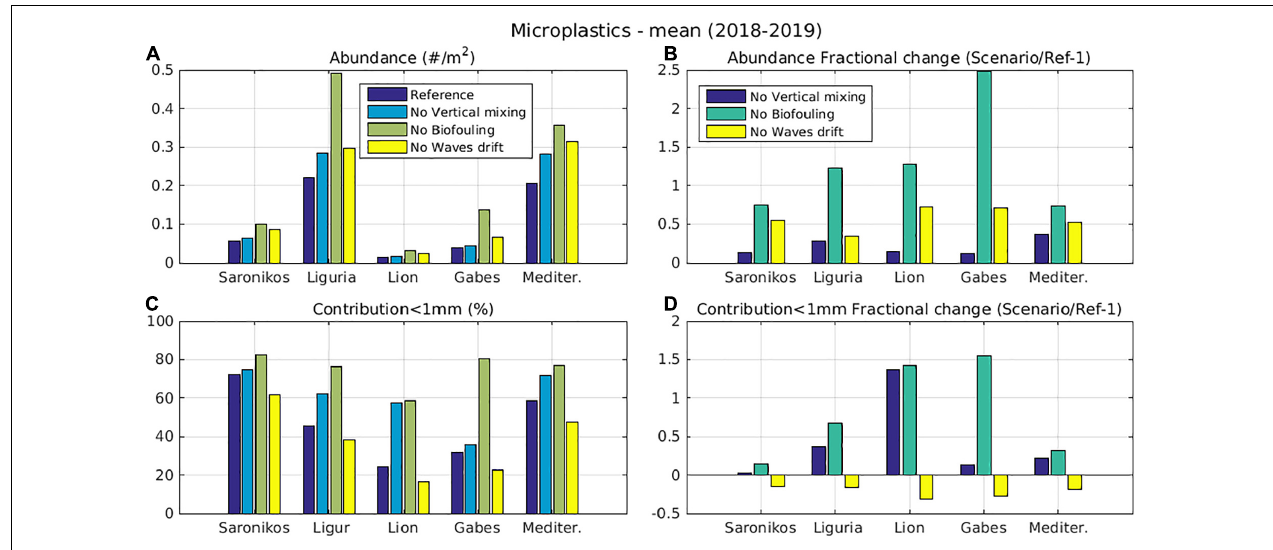
FIGURE 2 | Mean (2018–2019) simulated microplastics (A) concentration (items/m 2 ) (B) contribution < 1 mm (%), (C) concentration fractional change (Scenario/Reference-1), and (D) contribution < 1mm fractional change (Scenario/Reference-1), with the reference simulation and simulations without vertical mixing, waves drift, and biofouling, averaged in the four key study areas (Saronikos Gulf, Ligurian Sea, Gulf of Lion, and Gabes Gulf) and the